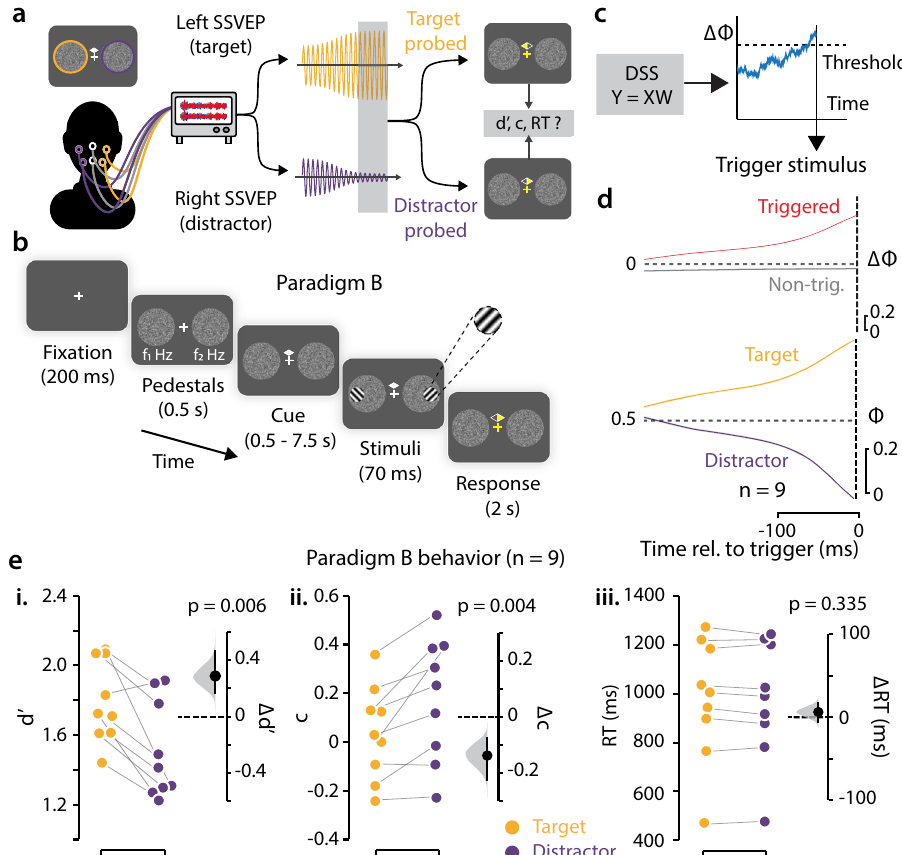
Fig. 4 A neurofeedback paradigm con fi rms ΔΦ as a robust marker for attention. a Schematic of a neurofeedback-based cBMI to investigate the effects of difference in SSVEP power across hemi fi elds on behavior. Yellow and purple traces: Momentary, target and distractor SSVEP power states, respectively. b Behavioral neurofeedback task (Paradigm B). Key task details are similar to those of paradigm A (Fig. 1b). On each trial, the pedestal on one side was predesignated as a target and the other, as a distractor. Participants were provided auditory neurofeedback based on the difference of SSVEP power between the target and distractor ( ΔΦ ), and stimulus presentation was triggered based on ΔΦ values (see next). On each trial, one of the two sides was (randomly) probed for stimulus orientation report ( fi lled yellow triangle). Other differences with paradigm A are discussed in the text ( “ Methods ” ). c Schematic of real-time stimulus triggering protocol. The recorded EEG data was preprocessed and projected, in real-time, onto the SSVEP DSS dimension (W), estimated in a baseline session (left). The projected data (Y), computed separately for the target and distractor pedestals, was used to estimate ΔΦ in real-time. When ΔΦ crossed a preset high threshold, grating presentation was triggered (right). d (Top) Mean ΔΦ traces for triggered (red) and non- triggered trials (gray), averaged across subjects, time locked to the triggering of the grating stimuli (dashed vertical line). Shaded region: s.e.m. (Bottom) Mean Φ traces on the target (yellow) and distractor (purple) side. Other conventions are the same as in the top panel. e (i) Discrimination accuracy (d ′ ) for target-side probed (yellow) and distractor-side probed (purple) trials for Paradigm B ( n = 9). Black dot and error bar: Mean effect size and 95% con fi dence interval, respectively, for the difference between d ′ across target and distractor probed trials. Gray histogram: bootstrap sampling distribution for effect size. Dashed horizontal line: Datum indicating zero effect size. (ii) Same as panel i, but for choice criterion (c). (iii) Same as panel i, but for reaction